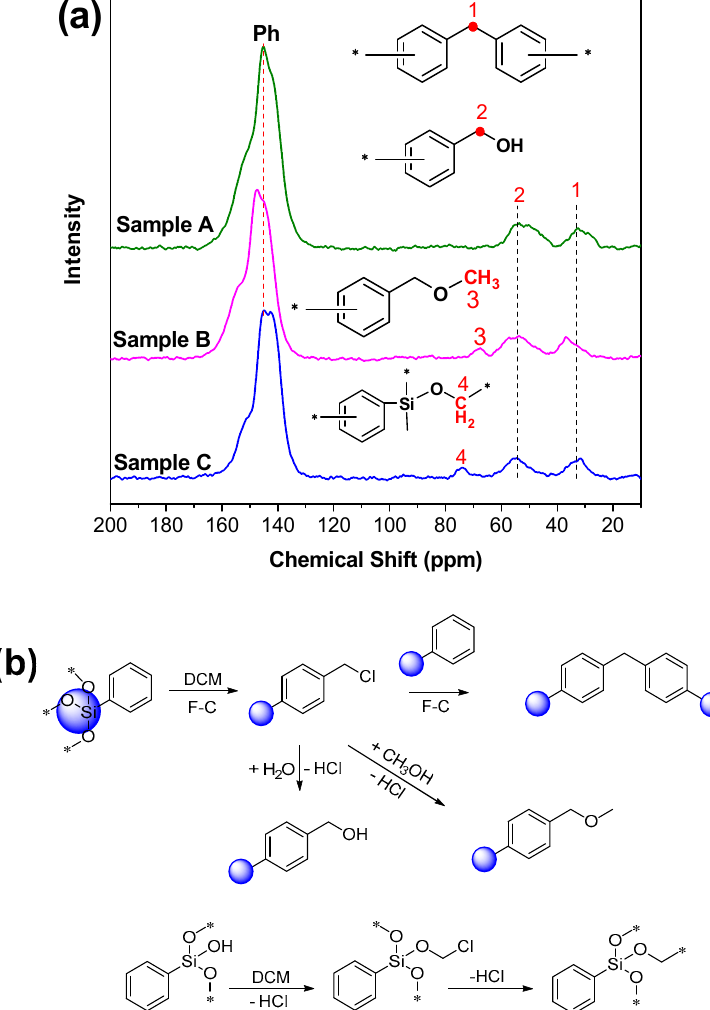
Figure 3. ( a ) Solid 13 C NMR of sample A, sample B, and sample C, and ( b ) illustration of the typical structural formation. F-C means the Friedel-Crafts reaction.